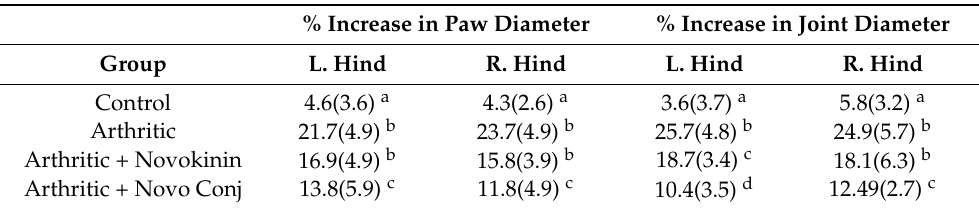
Figure 3. Treatment with novokinin conjugate (Novo Conj) restored body weight ( A ) and decreased arthritis index (AI) score ( B ). Data labeled with different letters (a, b, c, or d) indicate a statistical difference between groups where p < 0.05. Table 5. Percent change in paw and joints diameter in different treatment groups on day 24 compared to day 0.